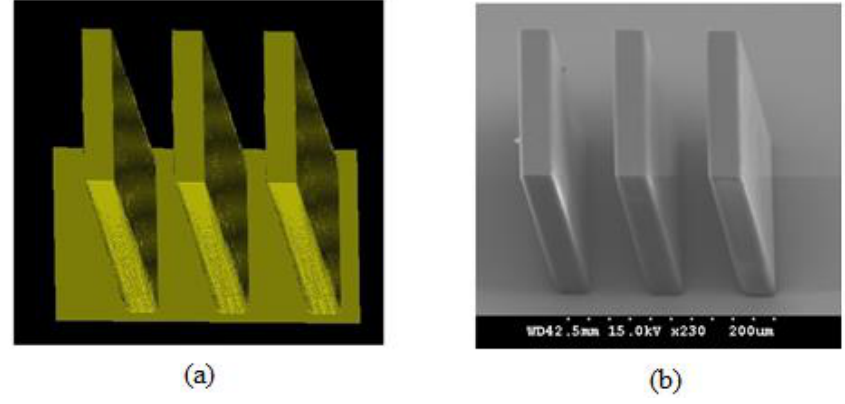
Figure 10. ( a ) Simulation result and ( b ) experimental result of the inclined UV lithography for 140 ±